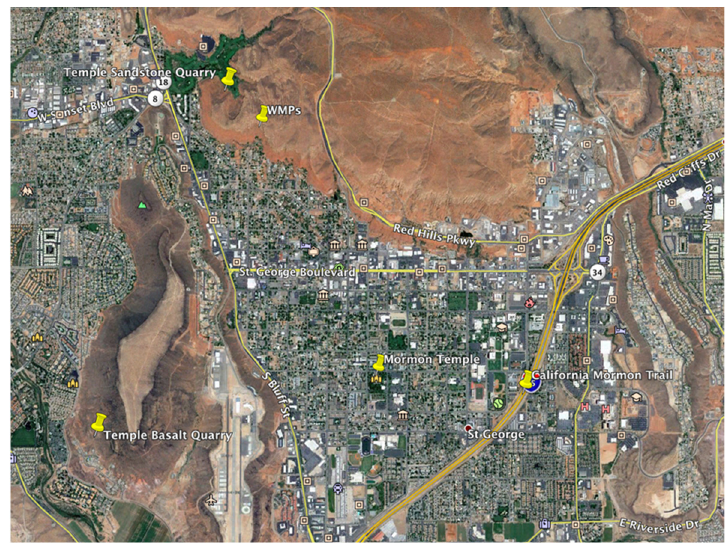
Figure 8. WMP site viewshed includes the Mormon Temple, temple sandstone quarry, and California Mormon Trail, with Temple basalt quarry nearby.